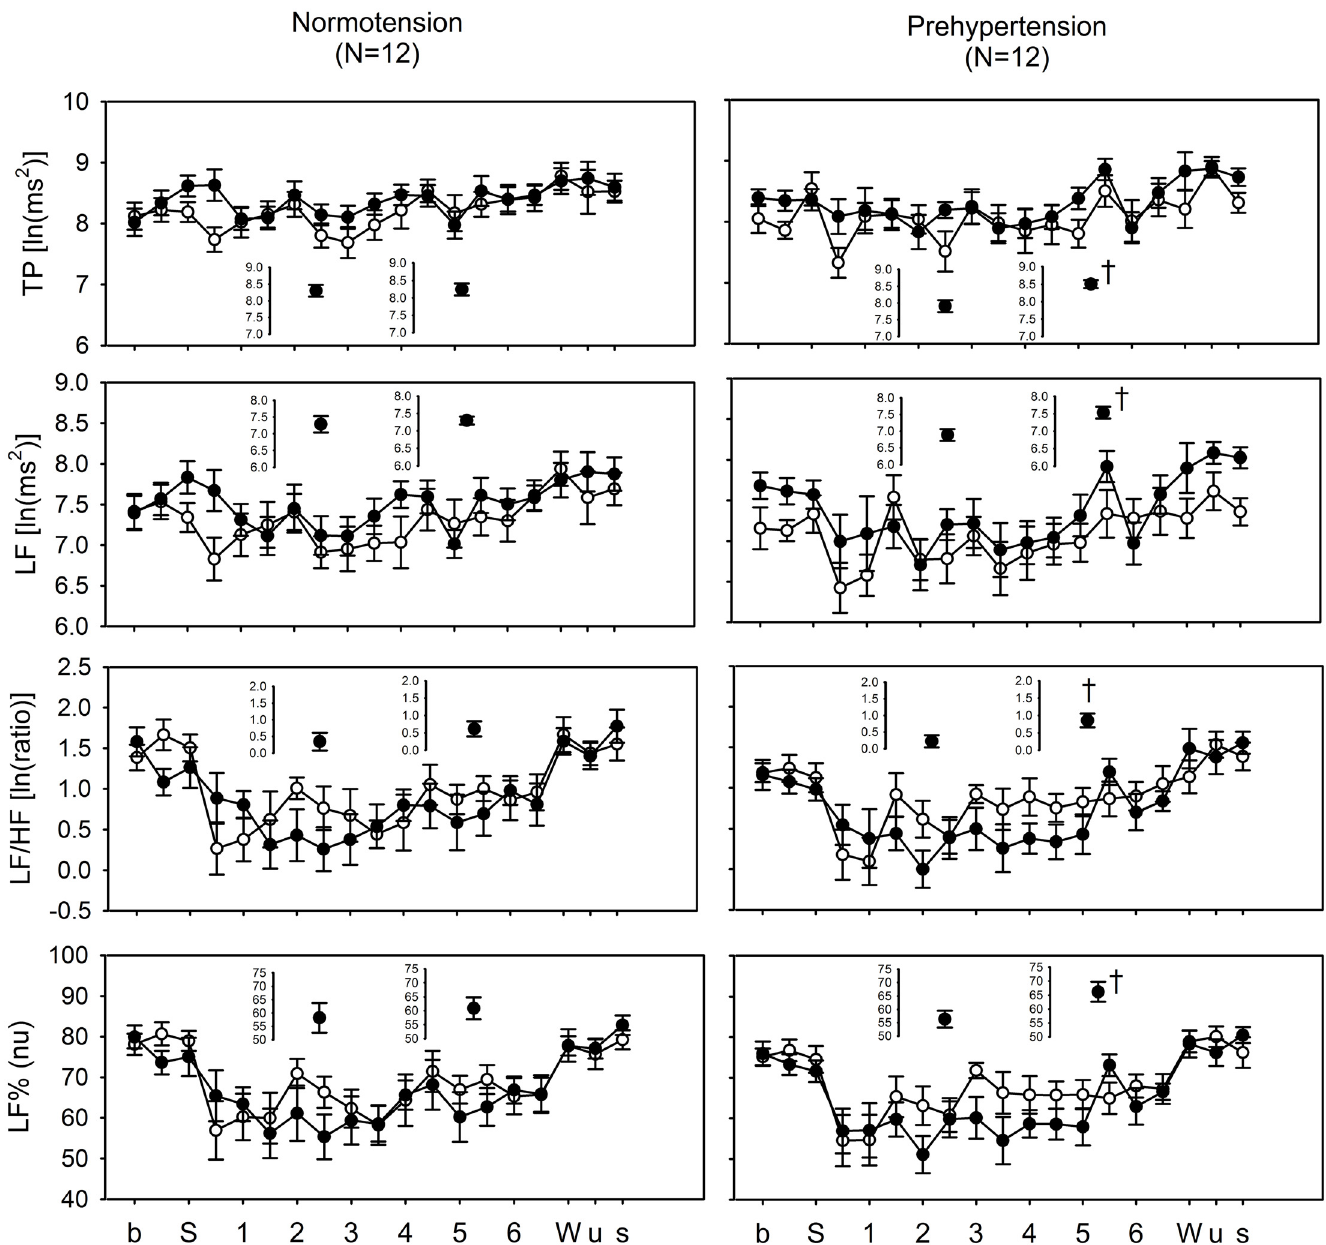
Fig 2. Diurnal patterns of indices of heart rate variability (HRV) for normotensives and prehypertensives under warm and cold conditions over the entire study. Plots of the short dashed and solid lines in the inserts show the average values of HRV indices from 2 to 2.5 hours and 5 to 5.5 hours under warm and cold conditions, respectively. A comparison of the average values of the HRV indices between 2 to 2.5 hours and 5 to 5.5 hours under cold exposure shows that there is a significant early-morning surge in TP, LF, LF/HF, and LF% among prehypertension subjects. † vs. average values from 2 to 2.5 hours, p < 0.05. Abbreviation: b, baseline recording; S, sleep; W, wake; u, uncover waking; s, sit; numbers 1 to 6 on the X axis indicated the time (hours) relative to S (sleep) state; TP, total power of HRV; LF, low-frequency power of HRV; LF/HF, low-frequency power to high-frequency power ratio of HRV; LF%, normalized low-frequency power of